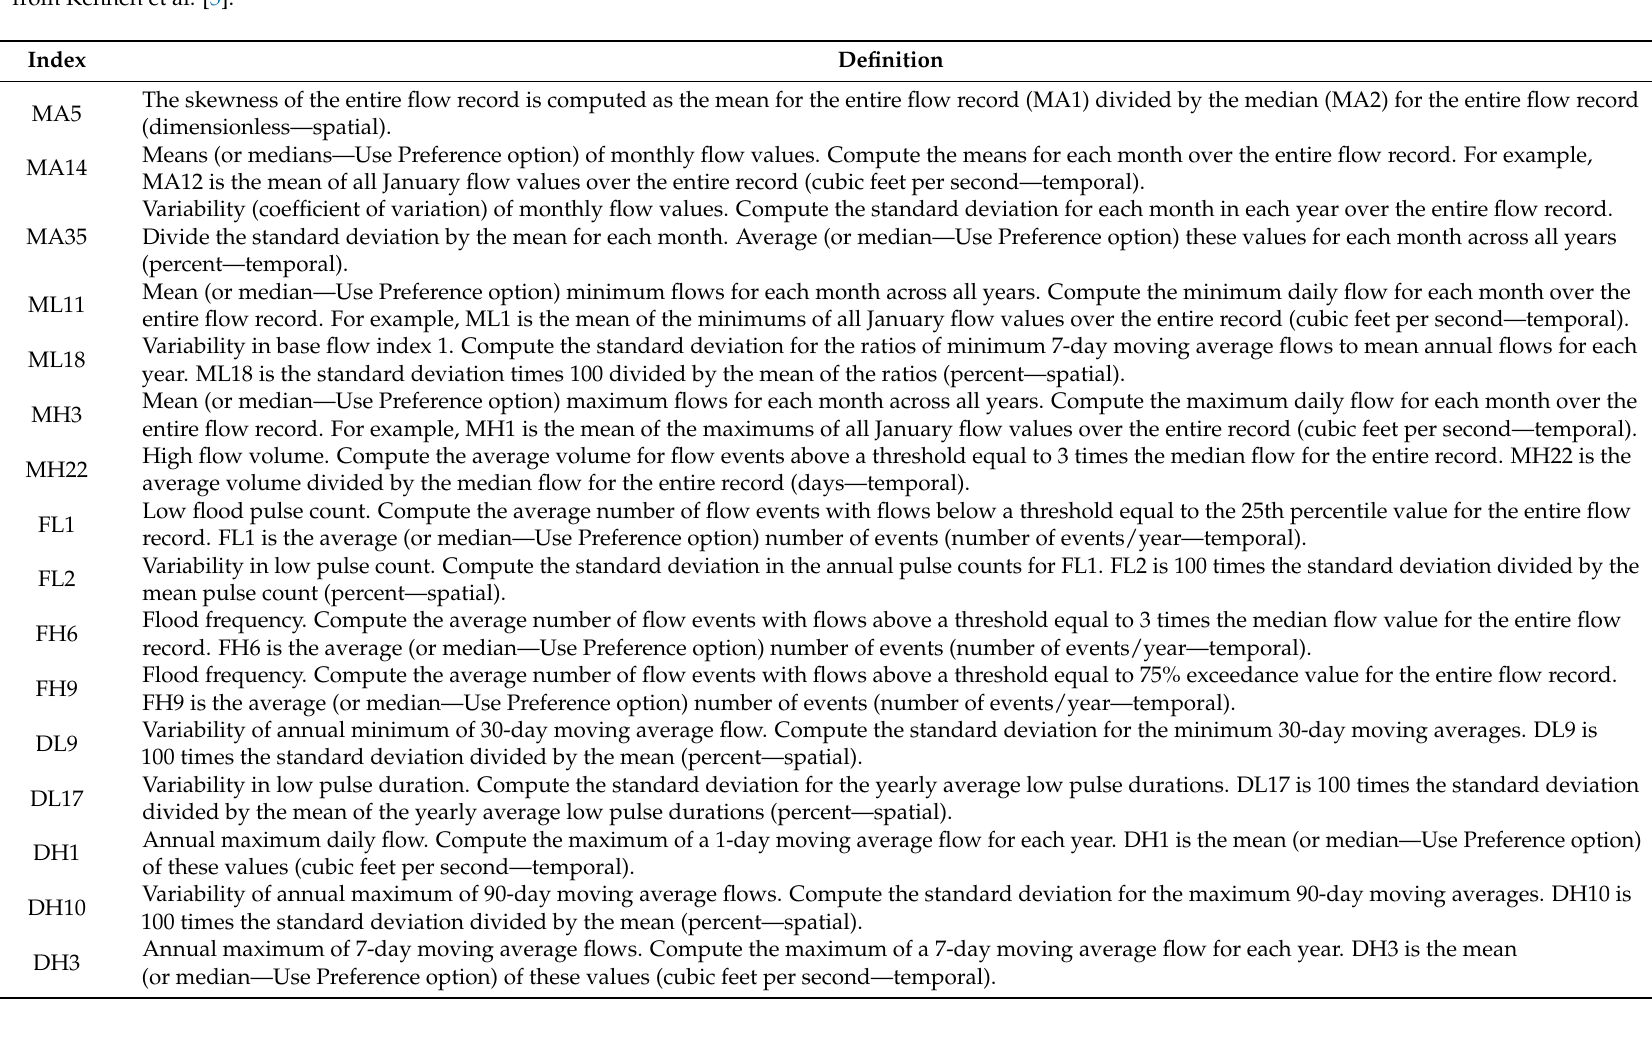
Table 2. Definitions for select hydrologic indices to quantitatively define major elements of the flow regime in Hinkson Creek, MO, USA. Definitions were sourced from Kennen et al.